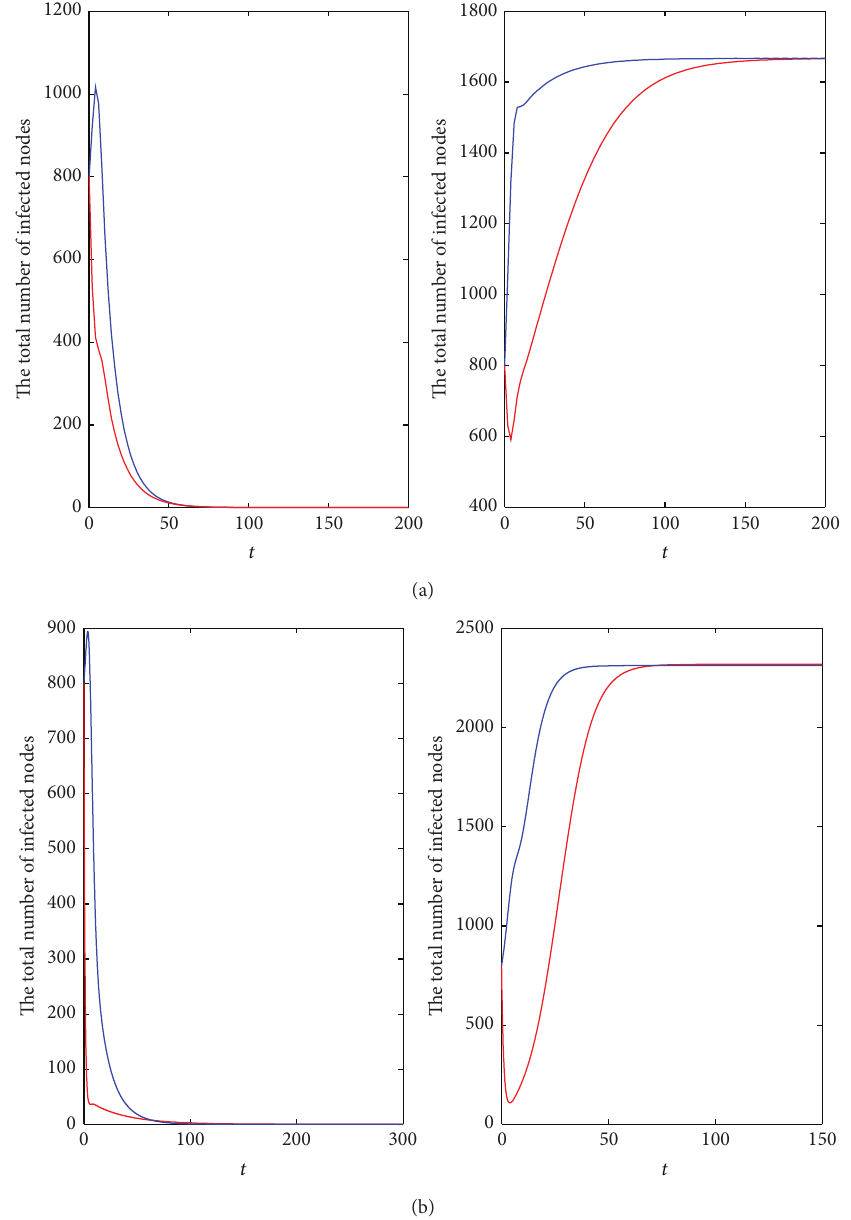
Figure 4: The consequences of different infectious period distributions on homogeneous (a) and BA scale-free (b) networks. In (a), 𝛽 = 0.013 , = 0.6 (left plot) and 𝛽 = 0.025 , 𝑅 𝑅 0